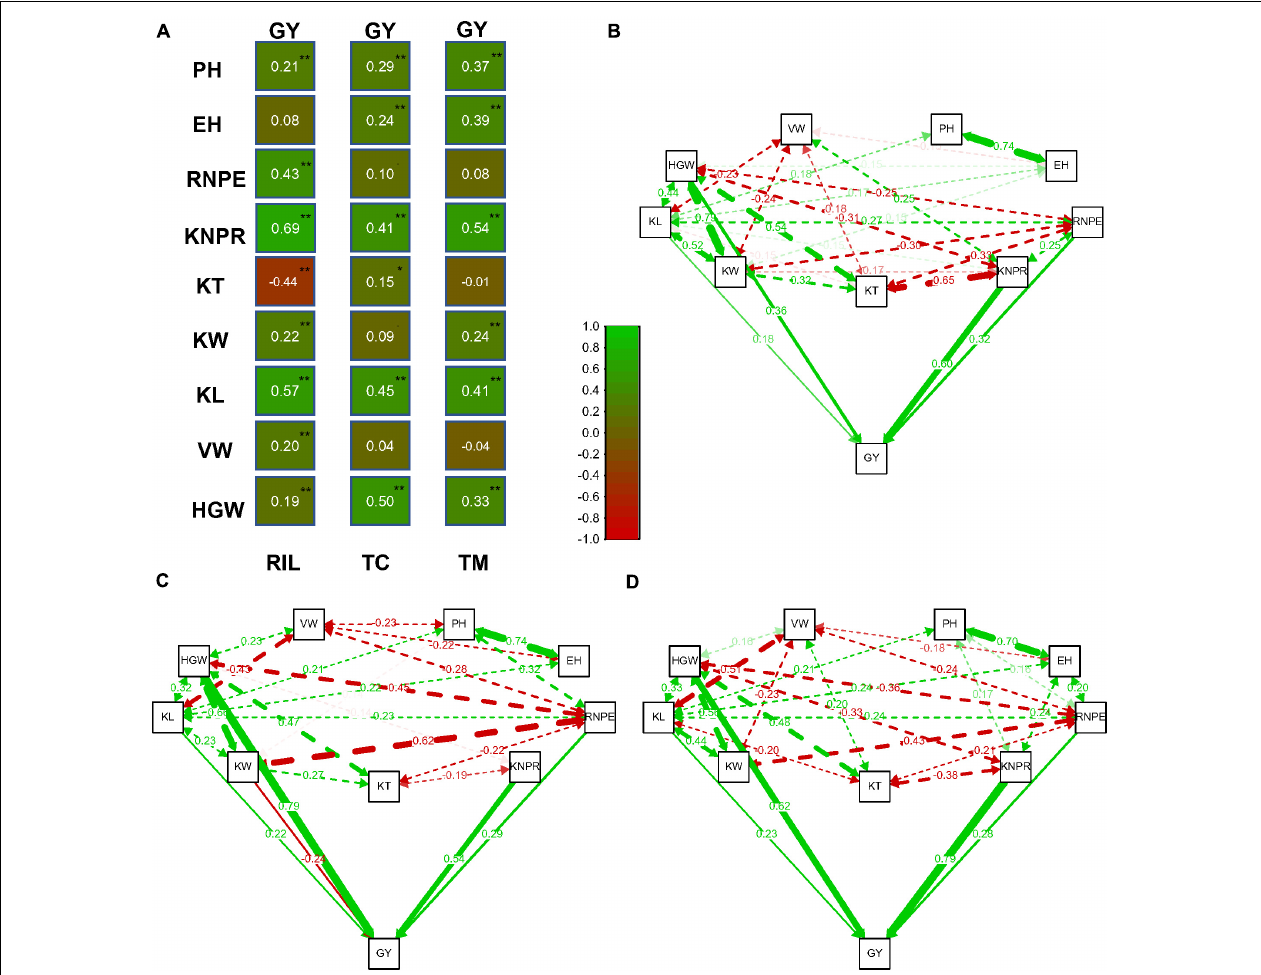
FIGURE 2 | Correlation and path analysis of 10 traits in the recombinant inbred line population developed by Ye478 × Qi319 (RIL), Chang7-2 × RIL (TC), and Mo17 × RIL (TM) populations. (A) Correlation coefficients between grain yield per plant (GY) and the other traits. (B) Correlation and path coefficients between GY and the other traits in the RIL population, (C) in the TC population, and (D) in the TM population. The lines toward GY are the path coefficients and the other lines among the traits are correlation coefficients. Only coefficients larger than 0.14 ( p = 0.01, n = 339) are displayed. **, significance at 0.01 level; *, significance at 0.05 level; PH, plant height; EH, ear height; RNPE, row number per ear; KNPR, kernel number per row; KT, kernel thickness; KW, kernel width; KL, kernel length; VW, volume weight; HGW, hundred grain weight; GY, grain yield per